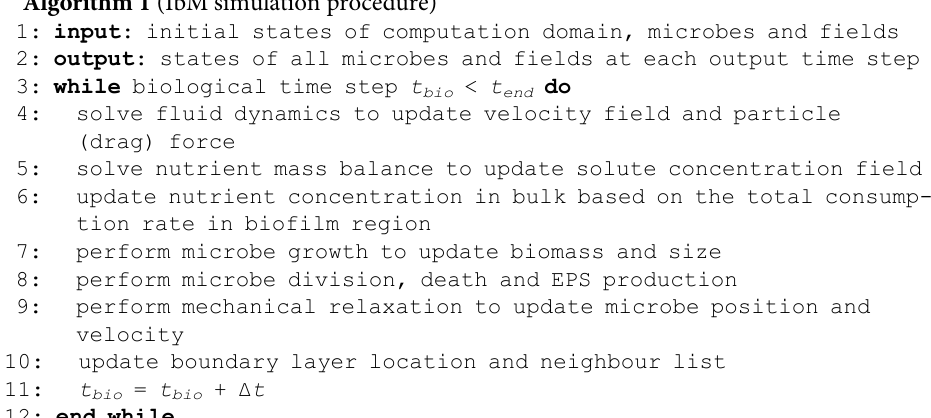
Algorithm 1 (IbM simulation